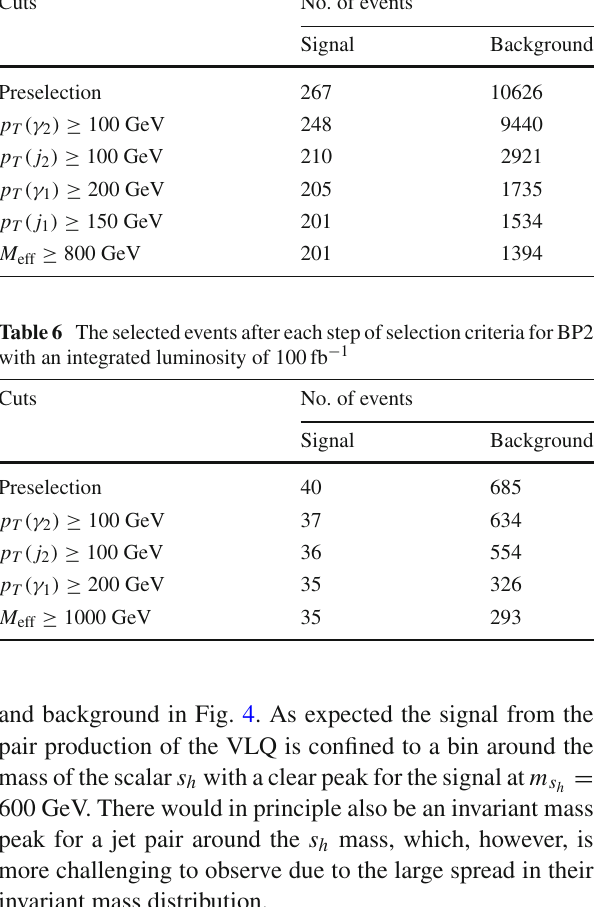
Table 5 The selectedevents after each step of selection criteria for BP1 with an integrated luminosity of 100 fb − 1 Cuts No. of events